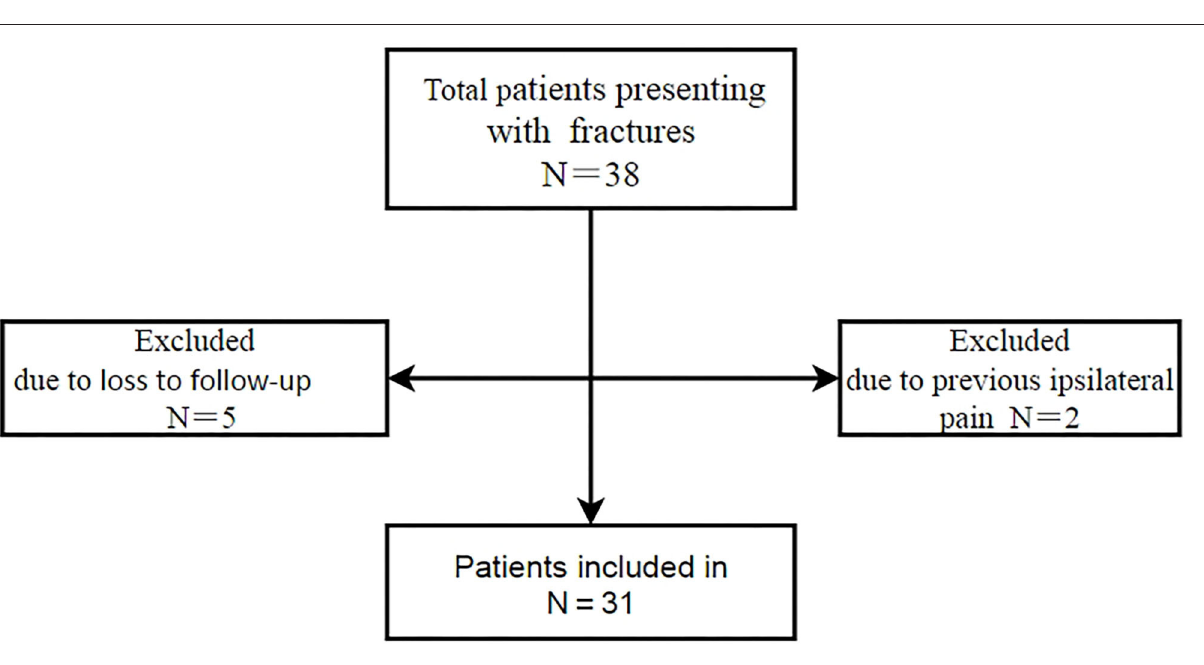
defined as a fracture located within one-fifth of the clavicle bone lying medial to a vertical line drawn upward from the center of the first rib according to the Edinburgh Classification